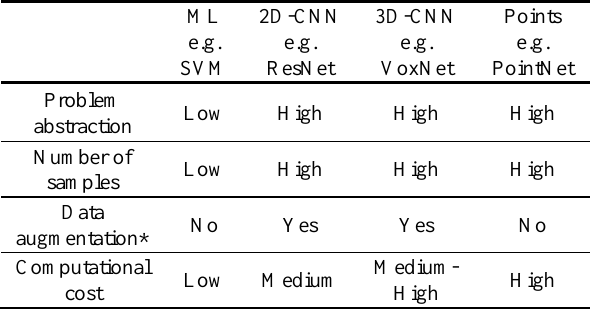
Table 1. Comparison between different Artificial Intelligence object classification methods for point clouds (*Data augmentation refers to generating several samples per object by rotations, not by adding